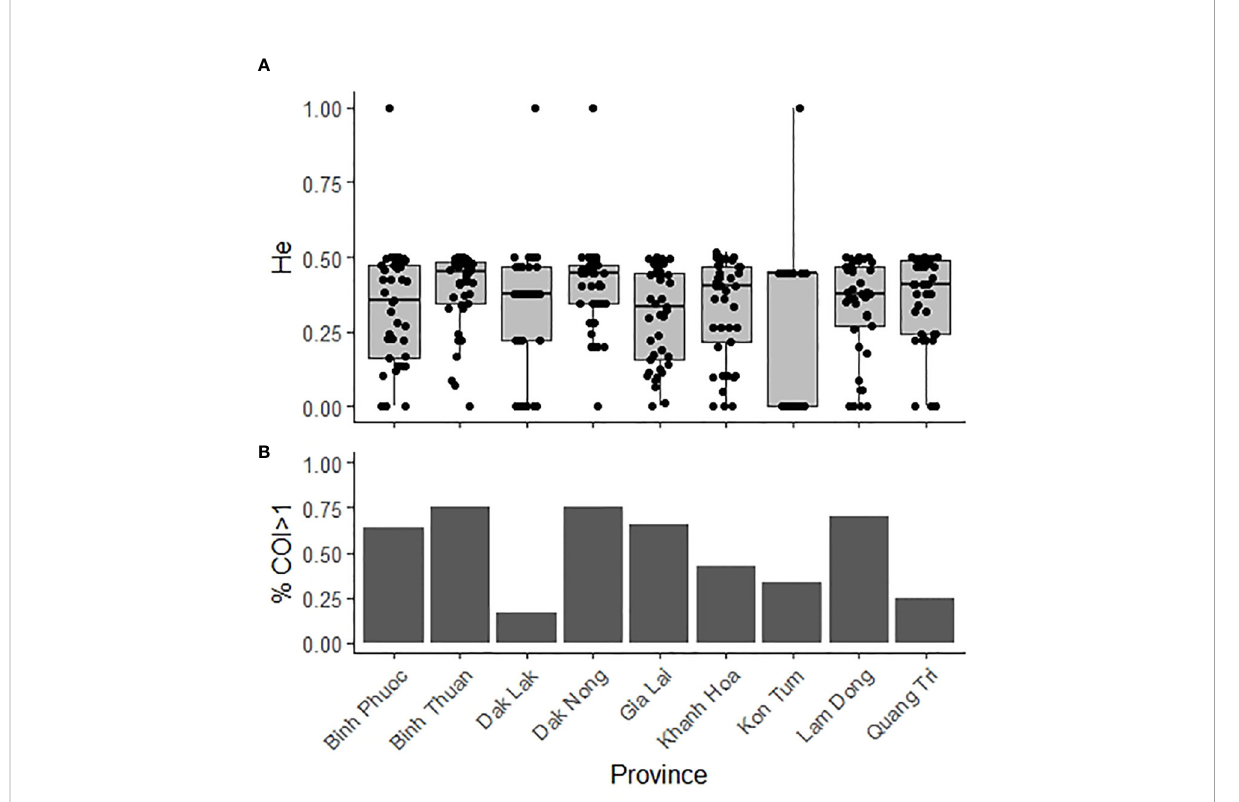
FIGURE 8 Genetic diversity and complexity of infection in nine provinces in Vietnam 2015-2019. (A) . Expected heterozygosity of 42-SNP Vietnam barcode positions (A) and proportion of multiple clone infections (B) in samples (n = 261) in Vietnam. He = Expected heterozygosity; COI = complexity of